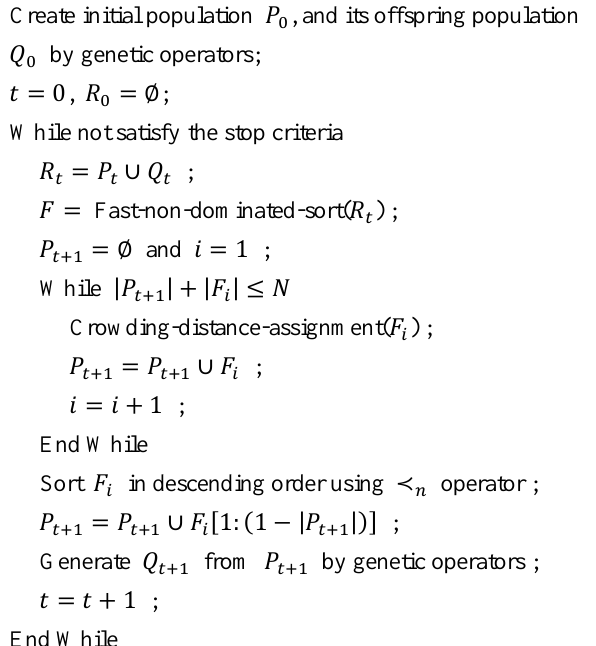
Fig.6 Schedule of Project 3(OS=0.7 RC=0.3)